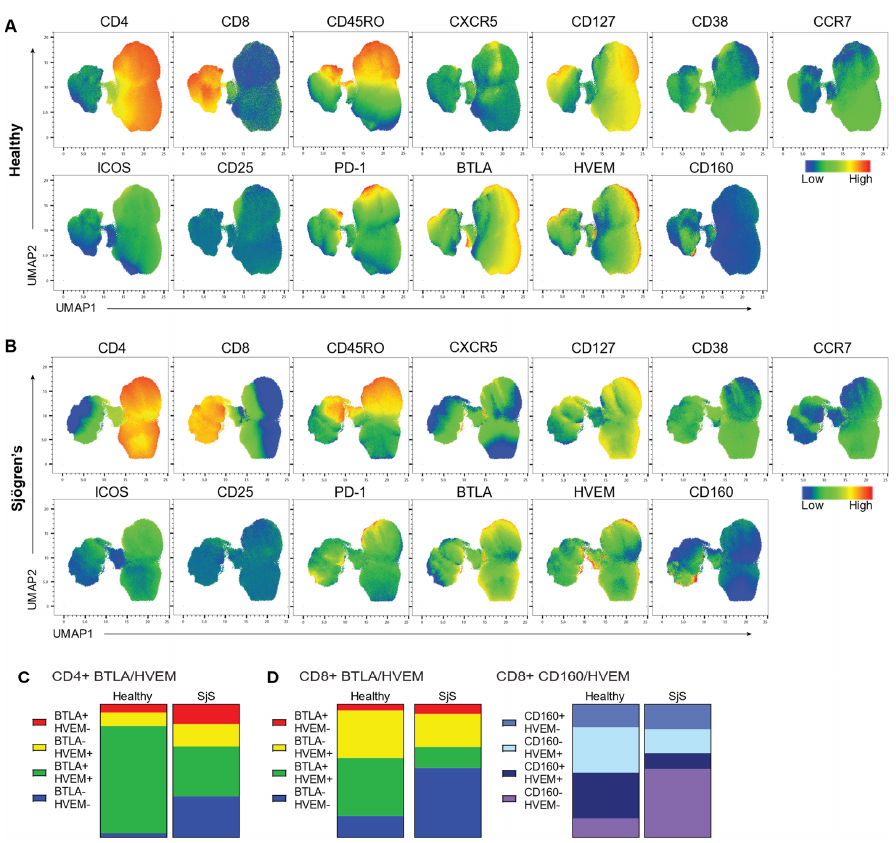
Figure 3. Checkpoint molecule co-expression in lymphocytes of SjS patients versus healthy controls. UMAP plots of flow cytometry data from ( A ) healthy control and ( B ) SjS lymphocytes. Color indicates cellular expression of labelled marker. ( C ) Summary of CD4 + lymphocyte BTLA/HVEM co-expression in healthy controls compared with SjS. ( D ) Summary of CD8 + lymphocyte BTLA/HVEM and CD160/HVEM co-expression in healthy controls compared with SjS. For ( C , D ), data are expressed as proportions of CD4 + or CD8 + T cells and are representative of n = 10 experiments.